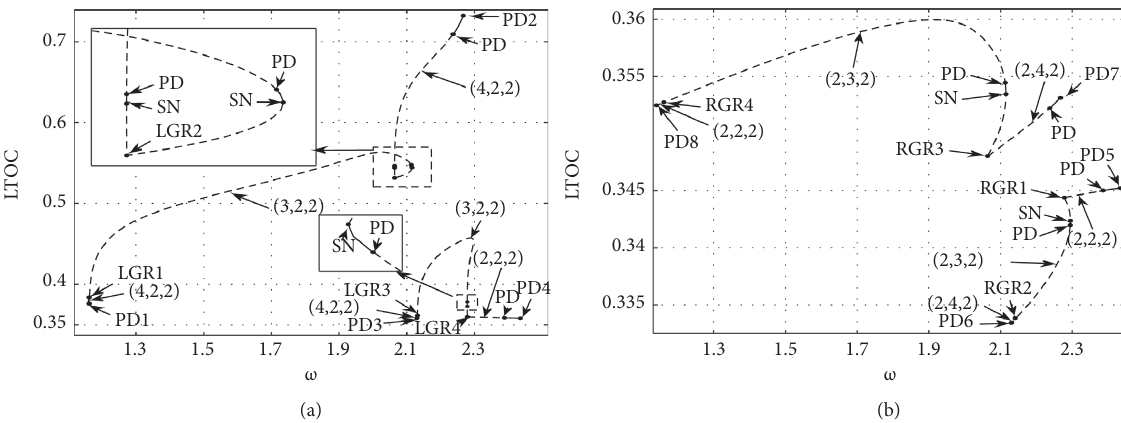
Figure 4: The result of the numerical continuation of the period-2 solution with respect to the frequency ω . The solid and dashed orbits denote stable and unstable solutions, respectively. Bifurcation points are marked by black dots. (a) Two orbits of period-2 originated from the period-doubling bifurcation points PD1 and PD3 of the period-1 orbit, respectively. (b) Two orbits of period-2 originated from the period-doubling bifurcation points PD5 and PD7 of the period-1 orbit, respectively.